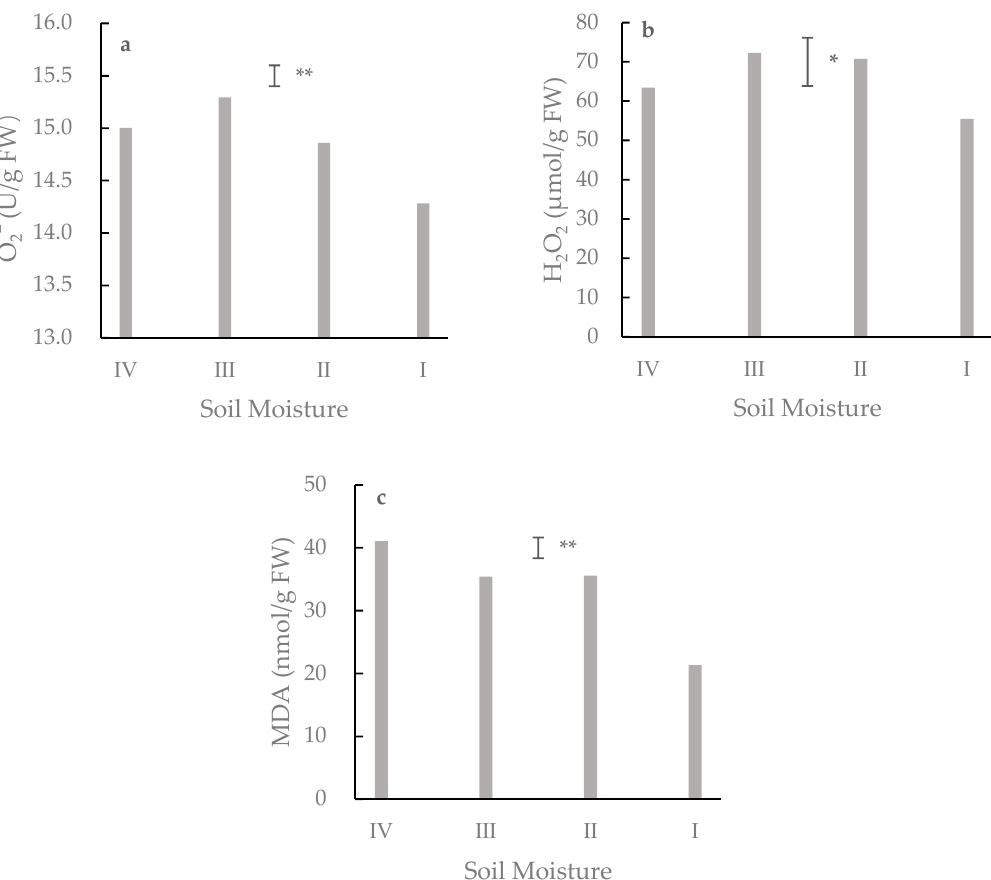
Figure 8. Content of ( a ) O 2 − , ( b ) H 2 O 2 and ( c ) malondialdehyde (MDA) in root of alfalfa under various soil moisture treatments (See Figure 2 for soil moisture abbreviations). *p < 0.05 ; ** p < 0.01.